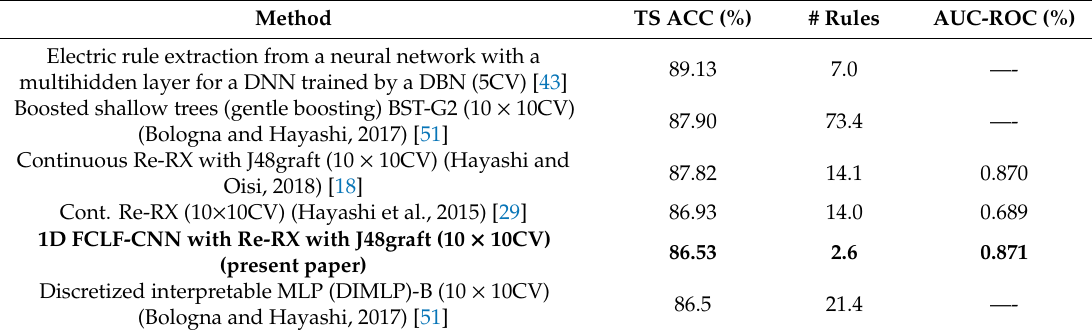
Table 7. Comparison of the performance of recent rule extraction methods and the proposed method (in bold) for the Australian credit scoring